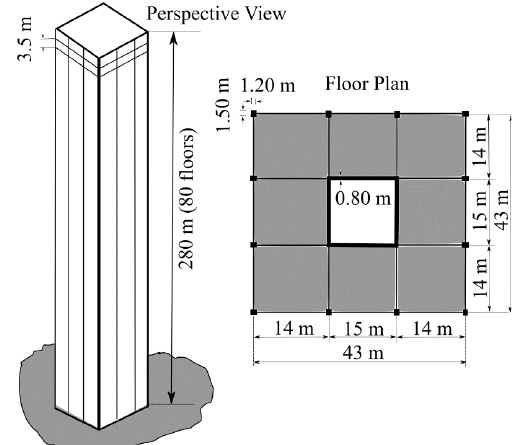
Figure 1. Tall building